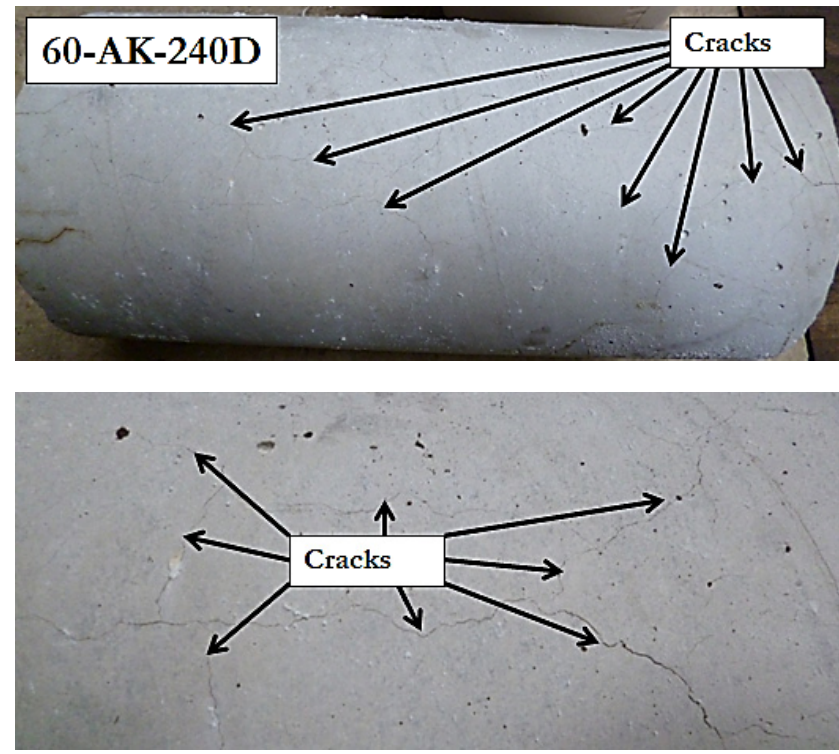
Figure 18. Typical surface aspect of 60-AK-240D concrete cylinders.